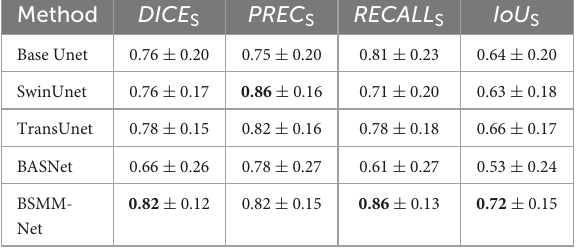
TABLE 1 Comparison of different models in slices (2D).